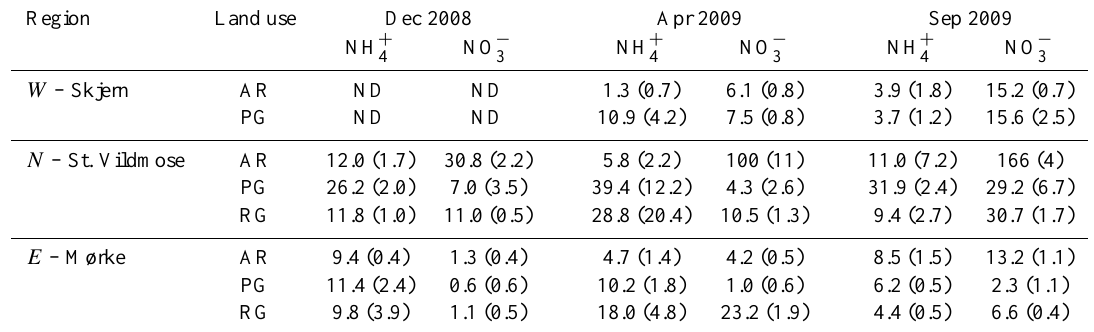
Table 4. Soil mineral N (0–20cm depth) was determined in the experimental areas on three occasions during the study. The data shown represent mean ± standard error ( n = 6). AR – arable crop; PG – permanent grassland; RG – rotational grass.